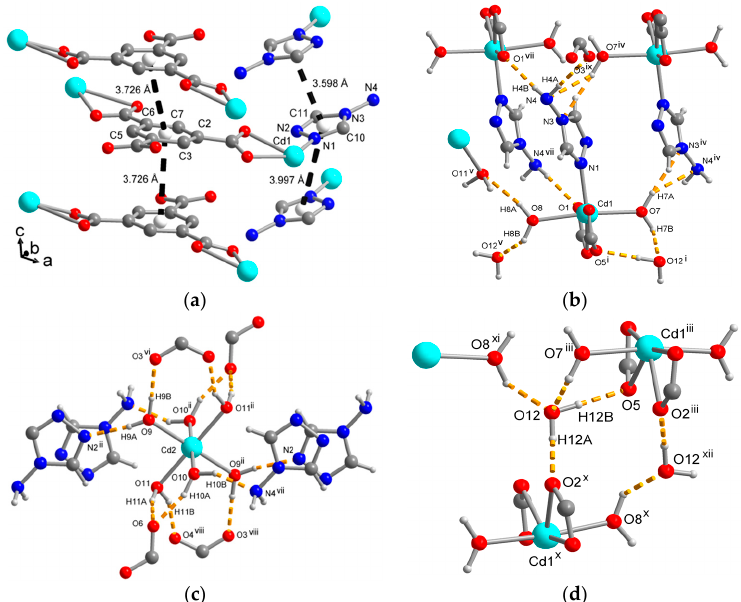
Figure 2. Supramolecular packing interactions in 1 : ( a ) π -stacking interactions with centroid-centroid contacts given. Hydrogen-bonding interactions shown separately for the different H-bond donors for clarity: ( b ) around the [Cd(H 2 O) 6 ] 2+ cations, ( c ) around the 4-amino-1,2,4-triazole (atr) ligands, and ( d ) around the crystal water molecule. Details of π -stacking interactions are given in Supplementary Information, details of H-bonds together with symmetry transformations are listed in Table 2. Additional symmetry transformations used in (d): iii = x – 1, y , z ; xi = x – 1, y , z – 1; xii = x , – y + 1/2, z + 1/2. The space which is created between the parallel anion chains is occupied by the cationic [Cd(H 2 O) 6 ] 2+ complexes and lattice water molecules (Figure 1c). Both [Cd(H 2 O) 6 ] 2+ and the crystal